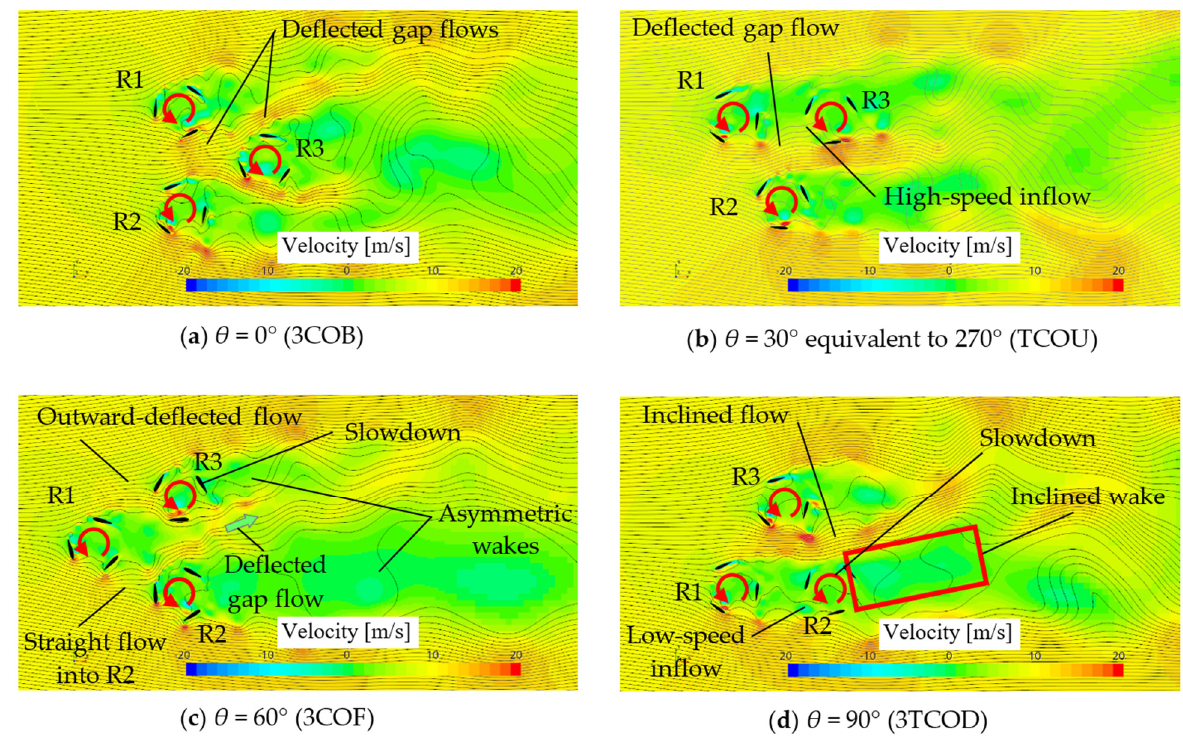
Figure 24. Color contours of flow velocity at g / D = 1 under V = 10 m/s in the 3CO configuration: ( a ) θ = 0 ◦ ; ( b ) θ = 30 ◦ ; ( c ) θ = 60 ◦ ; ( d ) θ = 90 ◦ .